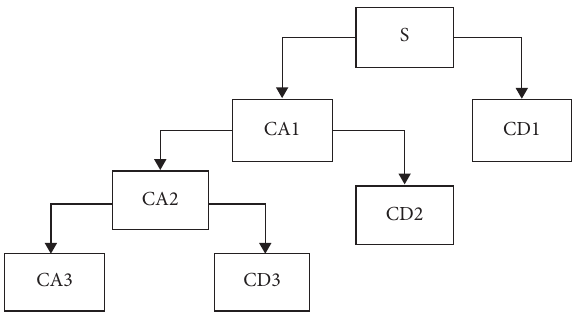
Figure 4: Sketch map of wave